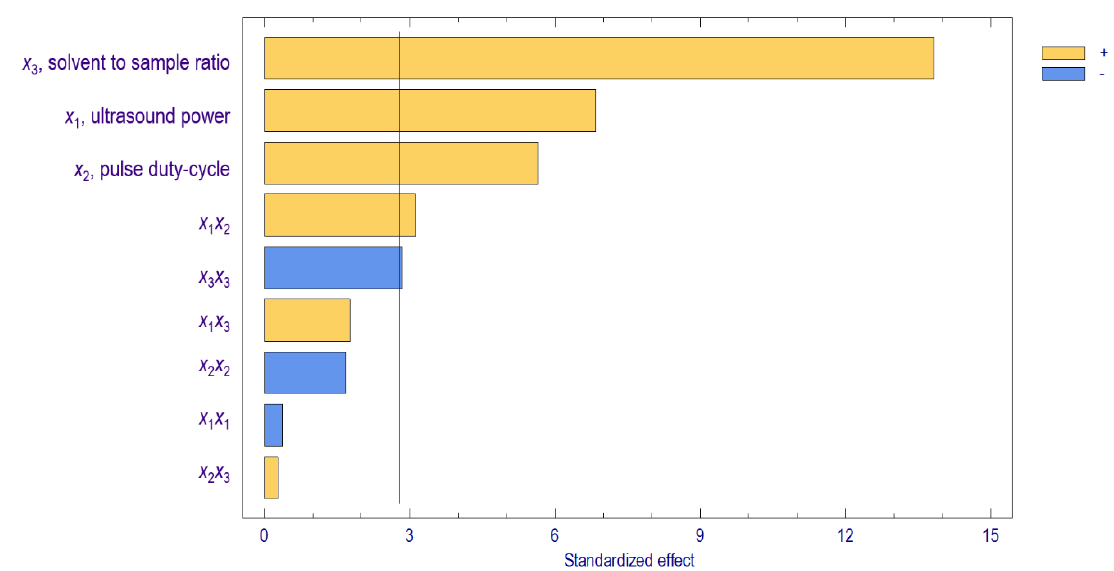
Figure 1. Pareto chart for the standardized effects of studied variables ( x 1 , ultrasound power; x 2 , pulse duty-cycle; x 3 , solvent to sample ratio). The vertical line crossing the bars notifies the corresponding factor has a statistically significant effect for a 95% confidence level. indicates a positive effect while indicates a negative effect.